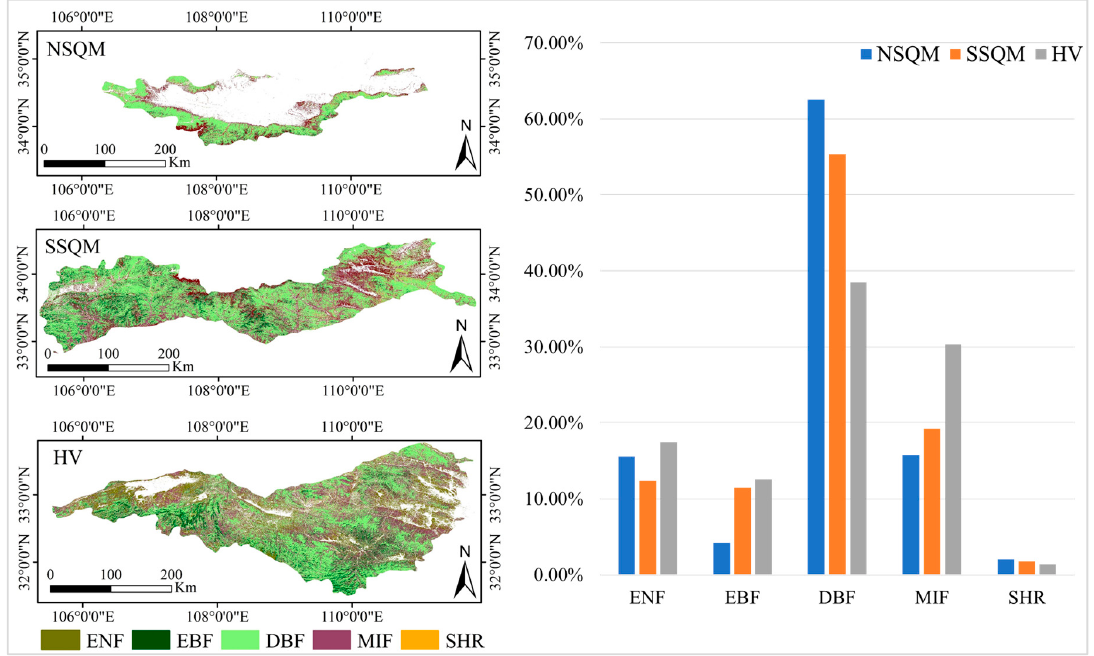
Figure 9. Composition and distribution of forest type in NSQM, SSQM, and HV. NSQM represents the north slope of QMS; SSQM represents the south slope of QMS; and HV represents Hanjiang valley located in the south region of 1 km contour line.